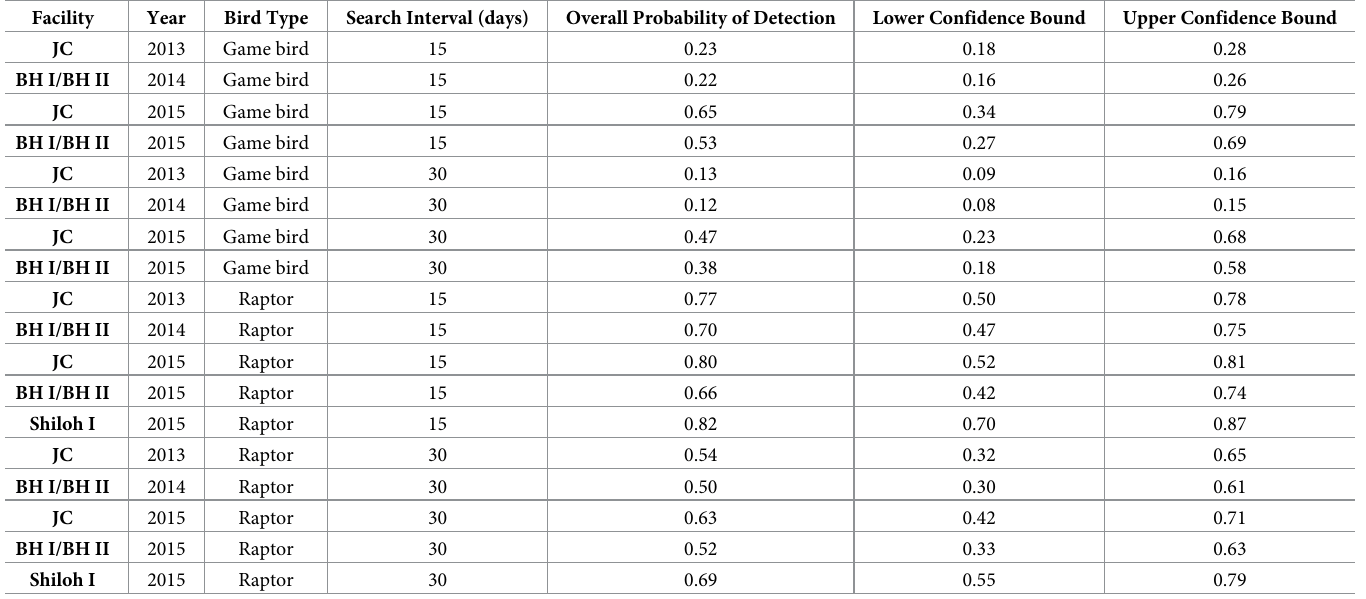
a Confidence bounds are for a 90% confidence interval.